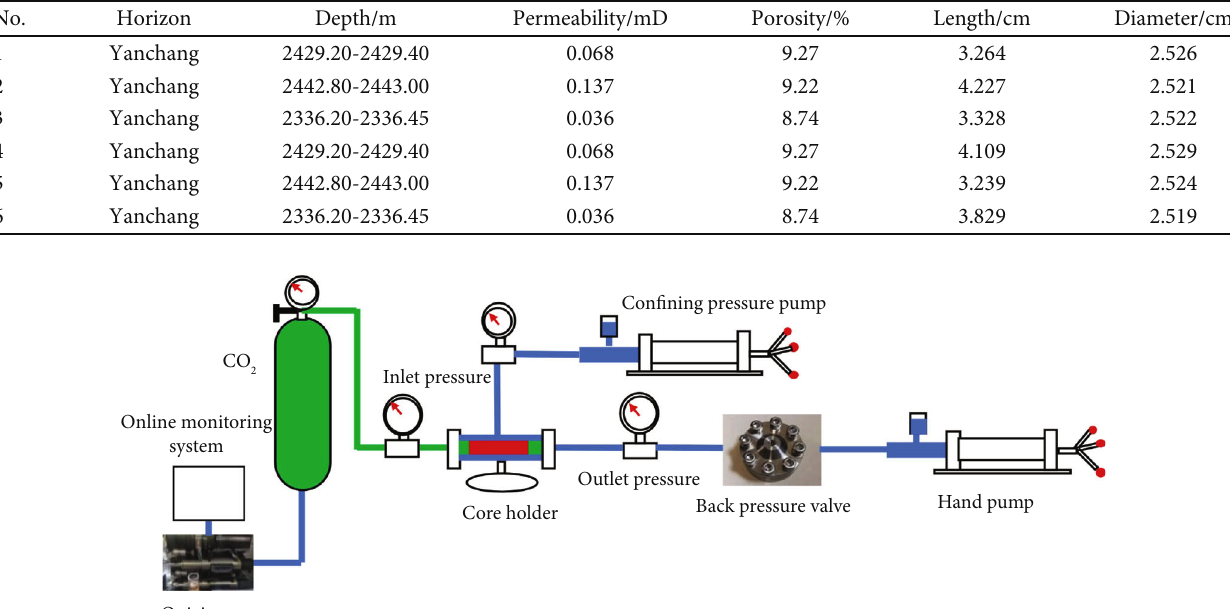
Table 1: Basic parameters of Chang 7 shale reservoir samples.